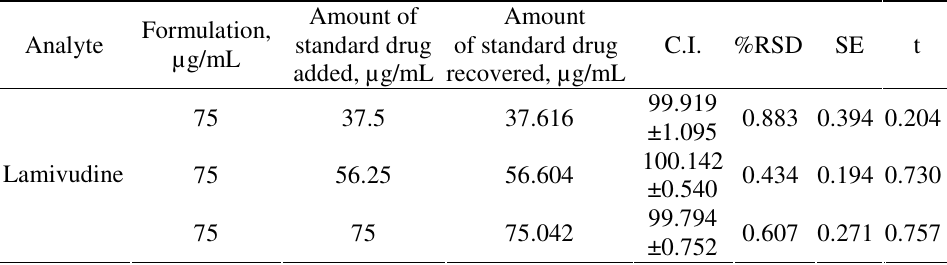
Table 5. Recovery study of